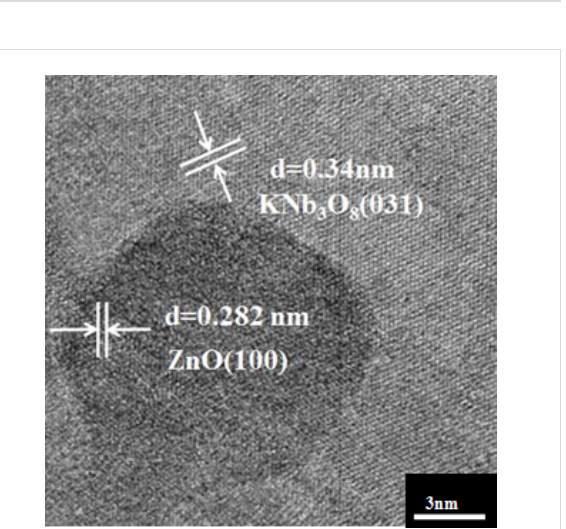
Figure 4: TEM image of the 2 wt % ZnO quantum dot/KNb 3 O 8 nano- sheet composite photocatalyst.